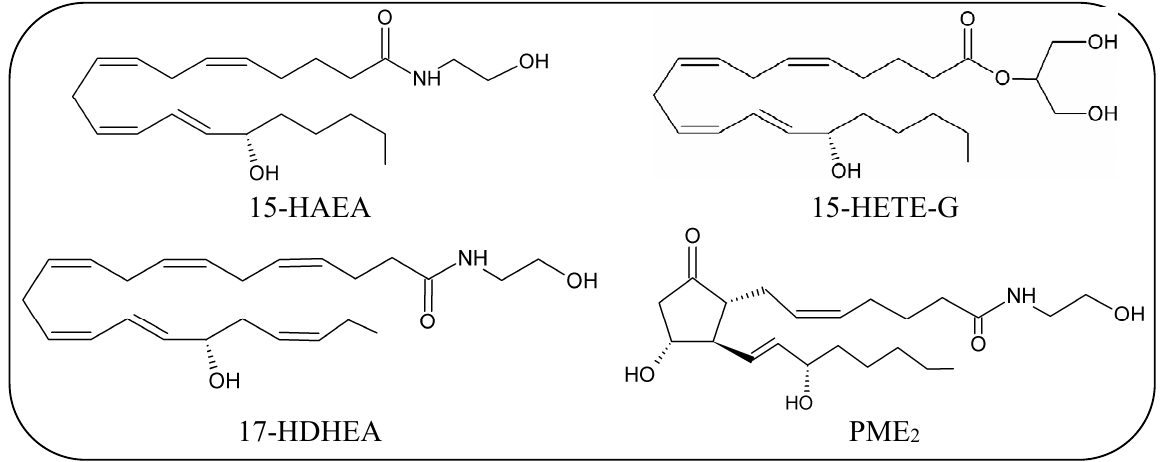
Figure 3. Chemical structures of the main products of oxidative metabolism of AEA and 2-AG.